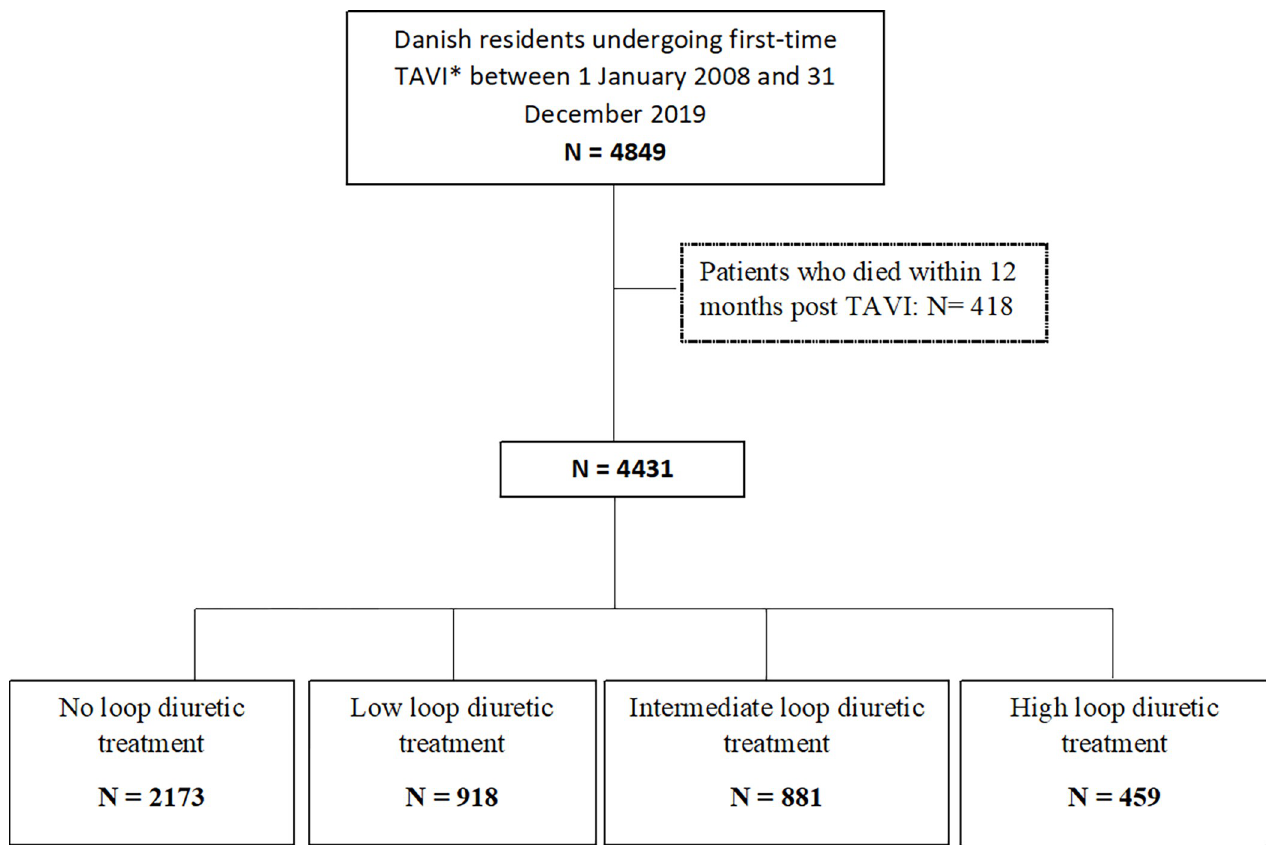
Fig 1. Flow chart of the study population selection process. Abbreviations: TAVI, transcatheter aortic valve implantation. Low loop diuretic treatment 1–40 mg of furosemide (or equivalent bumetanide); intermediate loop diuretic treatment 41–120 mg of furosemide; high loop diuretic treatment > 120 mg